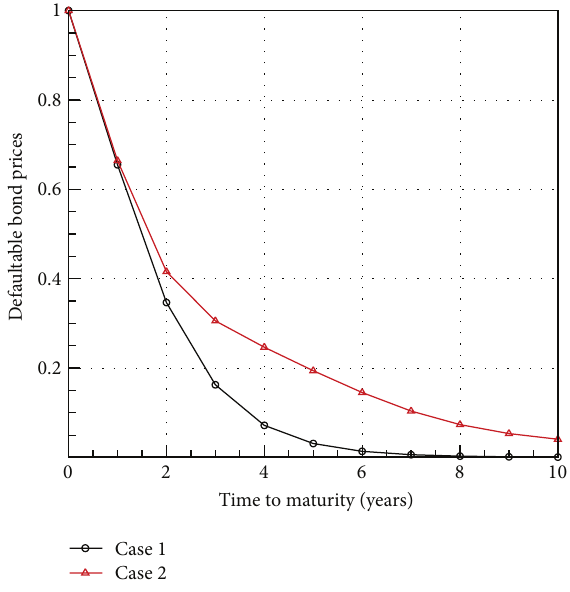
Figure 1: Defaultable zero-coupon bond prices.